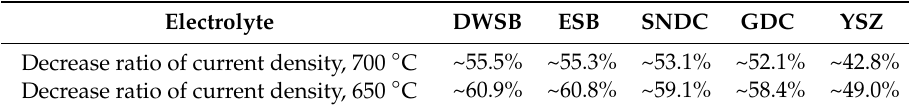
Table 4. The cell current density versus the change of the activation energy (by 10% increase of the activation energy) with di ff erent electrolytes.